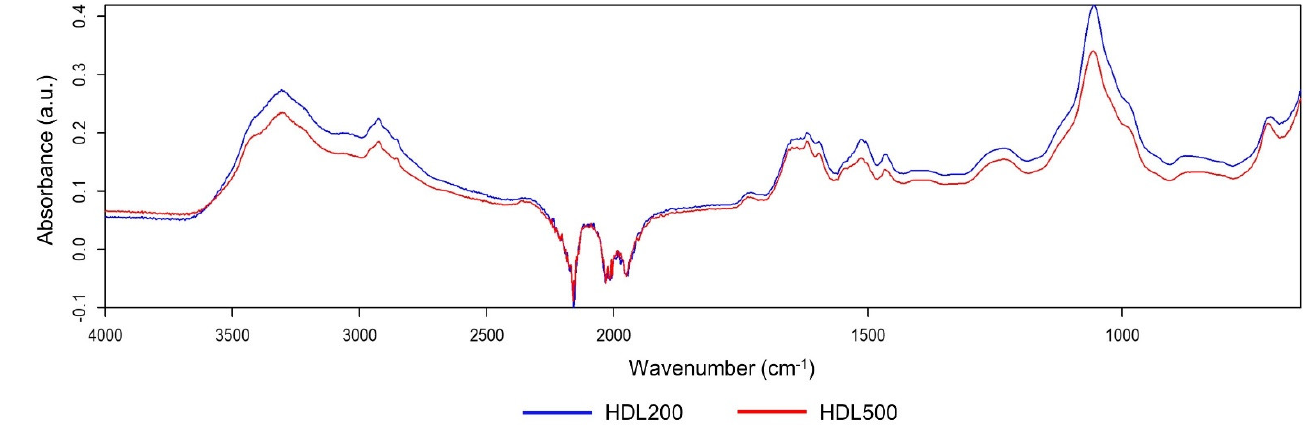
Figure 4. Representative results of the Quick Compare analysis of HDL200 (blue line) and HDL500 (red line). HDL raw spectra in the range of 4000–650 cm − 1 were used for analysis by OPUS 8.2.28 software. HDL200 and HDL500 had similar spectral patterns, with 99.60 ± 0.10% similarity.